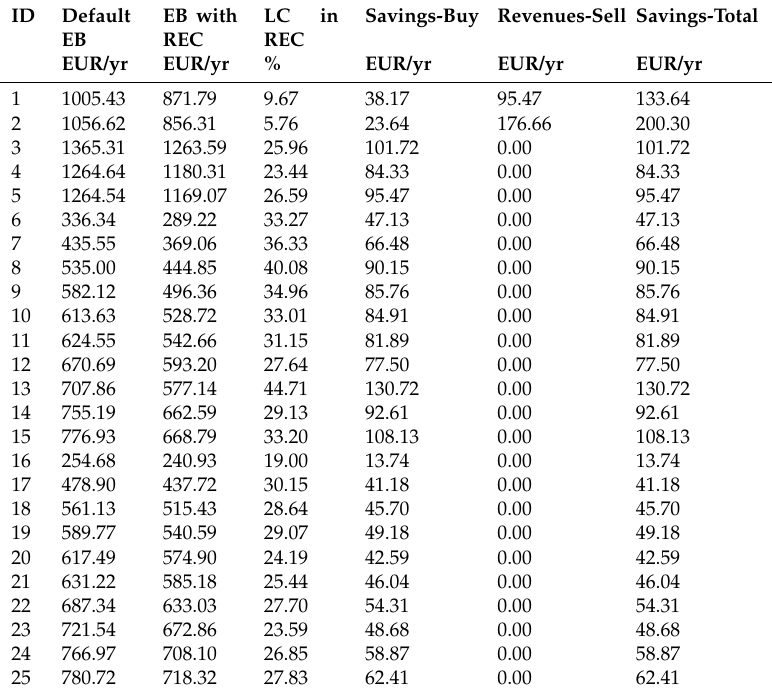
Table 10. REC of residential customers, a stand-alone PV plant and a commercial customer: Results for customers 1–25. Detailed explanation of the individual columns given in Table 5. Note, that revenues due to selling electricity within the community are zero for MAB residents 6–15 despite the availability of an in-house PV system, because the PV system is externally-owned.